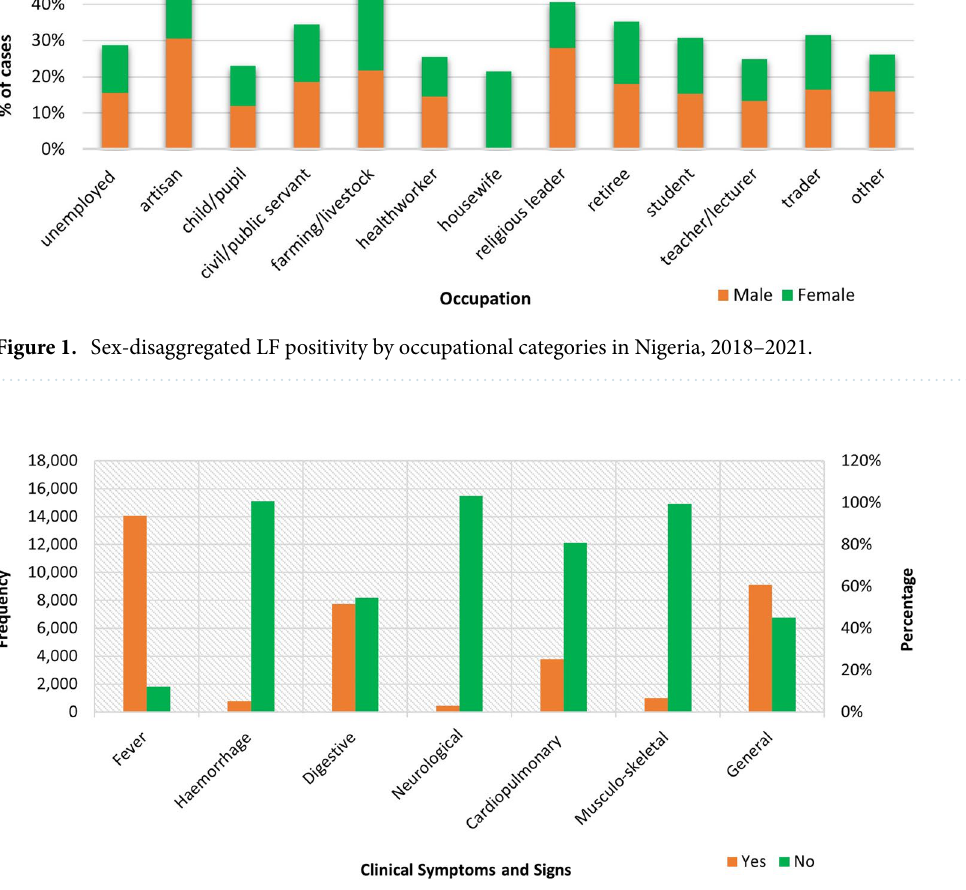
Figure 2. Clinical characteristics of lassa fever suspected cases in Nigeria, 2018–2021.